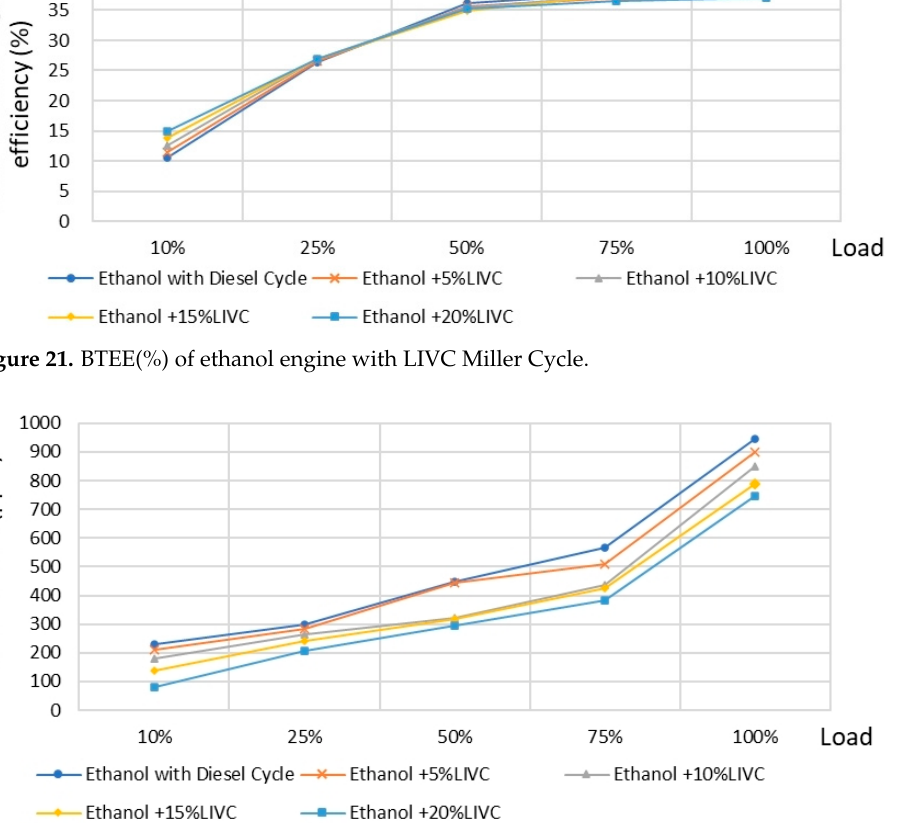
Figure 22. NOx emission(ppm) of ethanol engine with LIVC Miller Cycle.